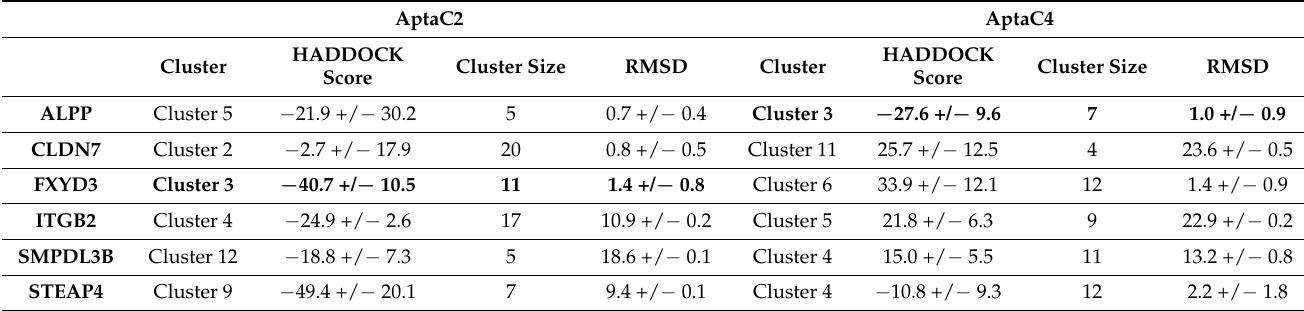
Table 1. Molecular docking parameters of possible targets in Caov-3 cell-line.